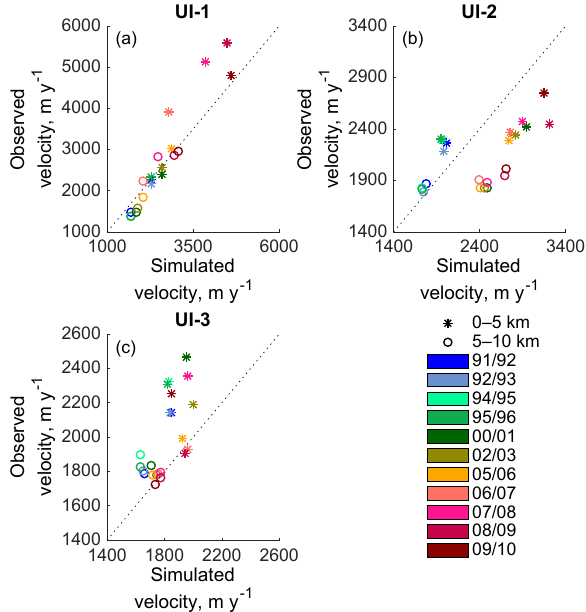
Figure 5. Observed vs. simulated ice surface velocity along the central flow lines of UI-1, UI-2 and UI-3. Stars mark mean ve- locity between 0 and 5km from the 2012 terminus, dots refer to mean values 5–10km upstream. Winter velocity maps for 1991/92, 1992/93, 1994/95, 2002/03, 2005/06 and 2008/09 are produced from data available from http://esa-icesheets-greenland-cci.org/ and described in Nagler et al. (2017). Winter velocity maps from 2000/01, 2007/08 and 2009/10 are given by MEaSUREs (Howat,